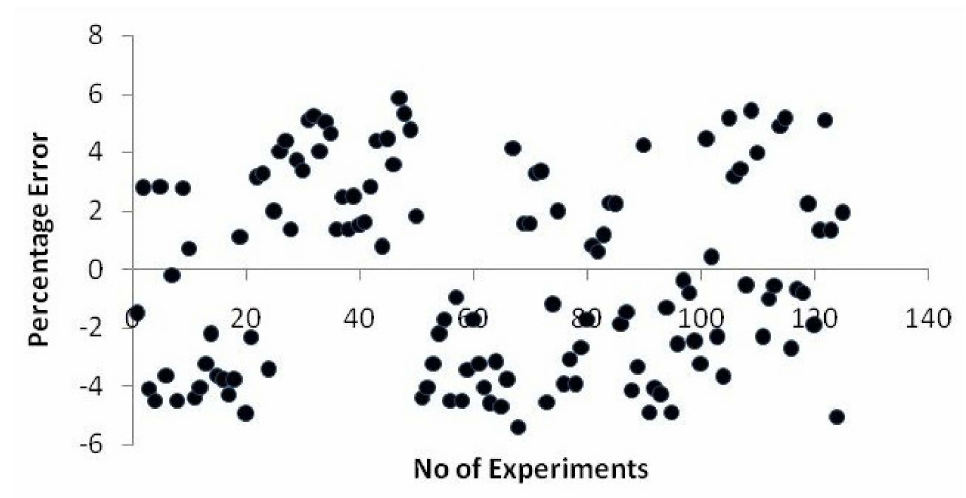
Figure 14. Network 4-4-3 error graph for angular distortion with a time gap between two